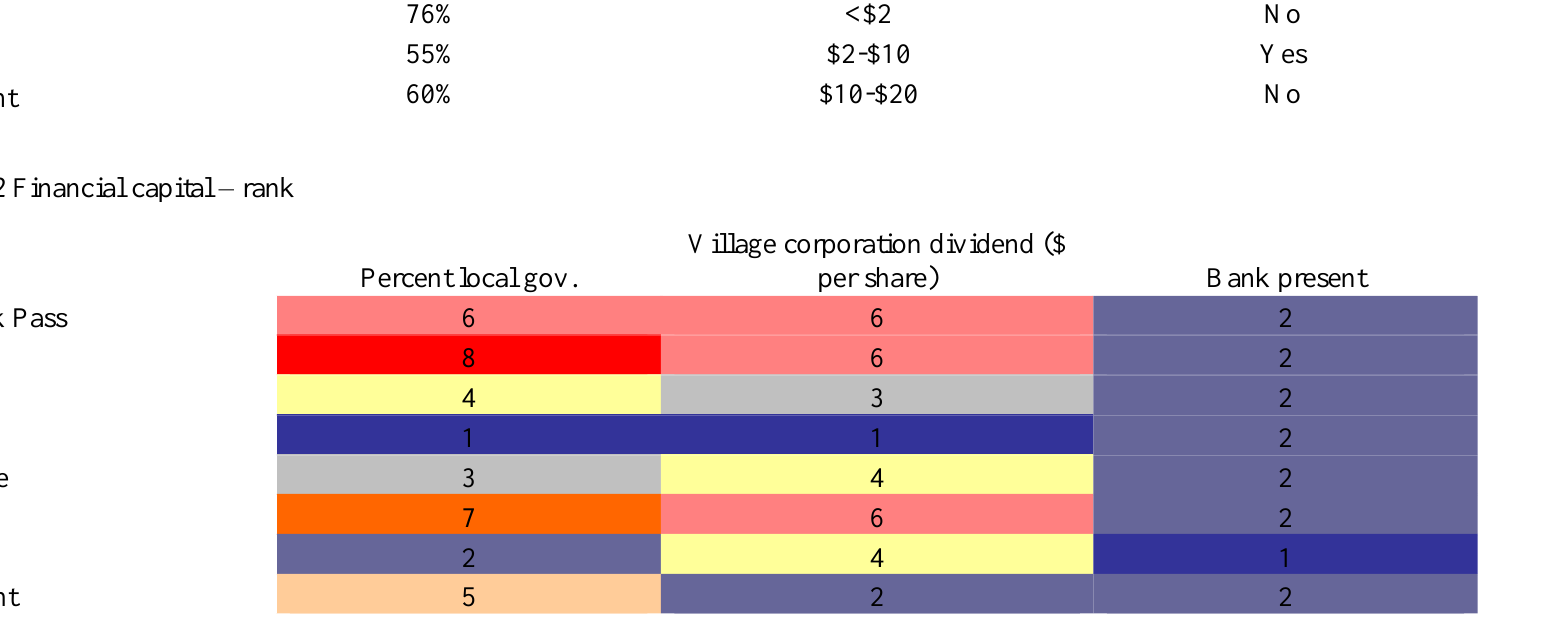
Table A2.13 Institutional capital –